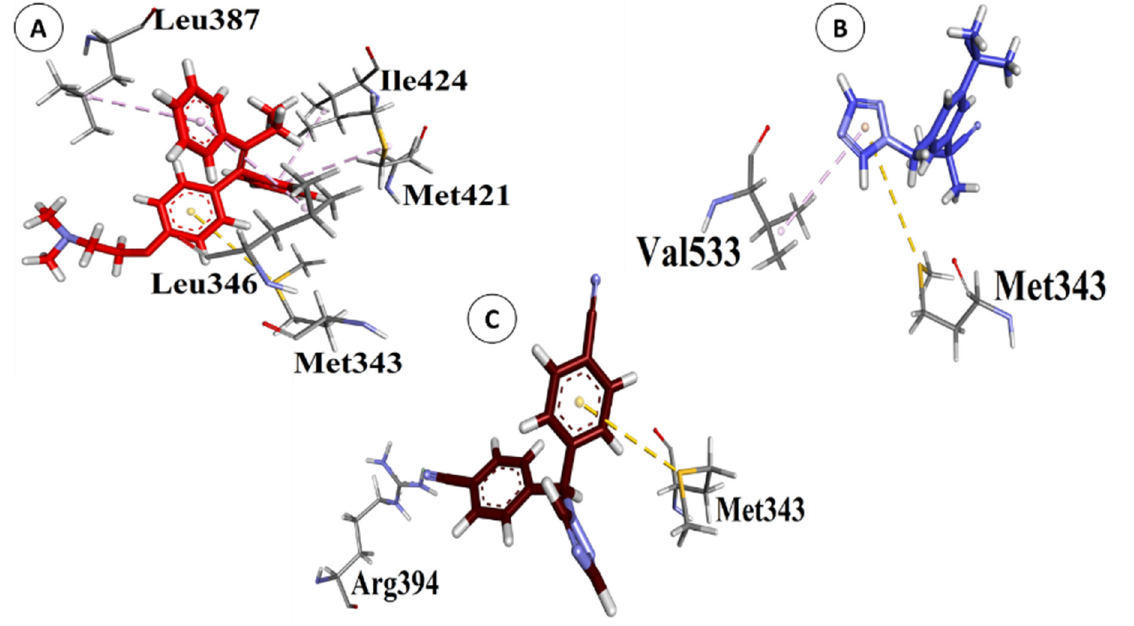
Figure 3. Three-dimensional interactions of Tamoxifen ( A ), Arimidex ( B ), Letrozole ( C ) with the binding site of ER α protein. Progesterone and testosterone were used as a negative control group as their scoring values are − 23.53 and − 23.95 respectively, as shown in Table 3. Previous research reveals that adding an androgen to estrogen treatment lowers mammary epithelial proliferation and ER expression, implying that androgens may protect against breast cancer in the same way as progesterone does. In the past, androgens were used to treat breast cancer with moderate effectiveness [45]. There are mixed theories about these hormones, as some claim they down-regulate breast cancer progression, whereas some claims they